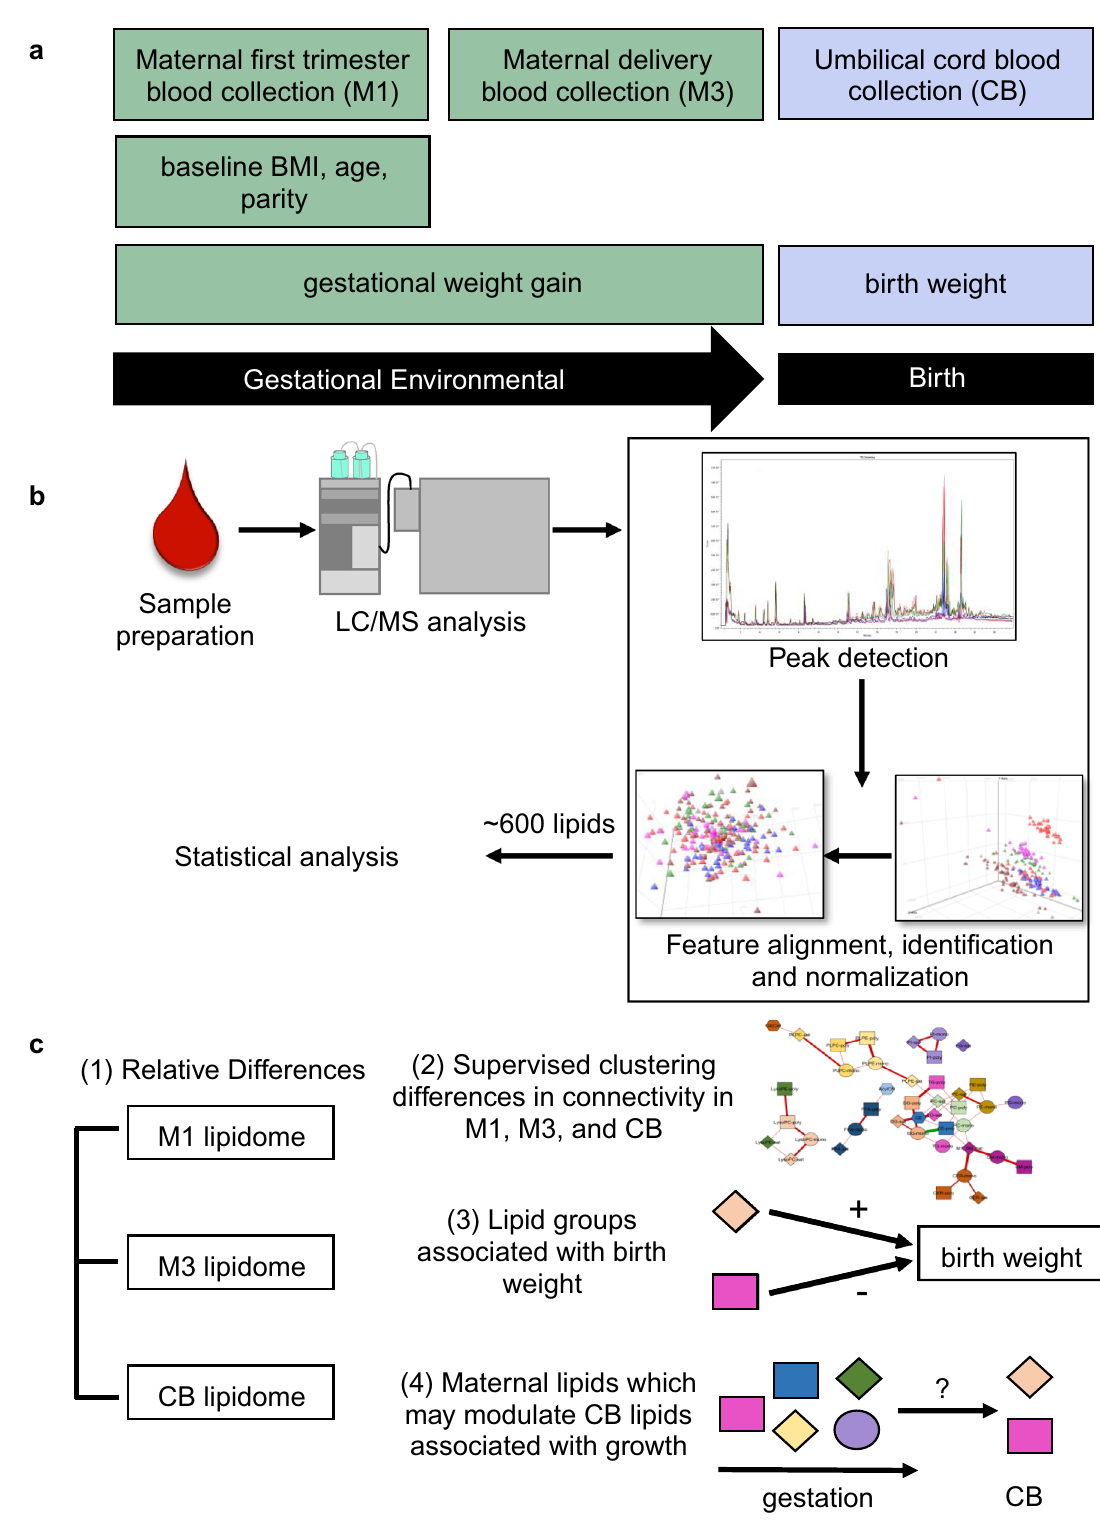
Figure 1. Study design and lipidomics analysis strategy. ( a ) Women were recruited into the Michigan Mother-Infant Pairs Study at their first prenatal appointment between 8 and 14 weeks pregnancy (M1). Venous blood samples were collected at this visit, along with weight, height, and demographic information. At delivery, maternal venous blood samples (M3) and cord blood samples via venipuncture from the umbilical cord (CB) were collected, as well as birth weight. ( b ) Untargeted shotgun lipidomics was conducted on maternal first trimester, delivery, and cord blood plasma. After peak detection and data normalization, 573 lipids of multiple classes were identified. ( c ) Statistical analysis for this manuscript classified (1) relative differences in the lipidome across pregnancy (paired t-test), (2) differences in the connections of lipid groups between M1, M3, and CB (debiased sparse partial correlations), (3) lipid groups associated to birth weight (linear regression), and (4) M1 and M3 lipids that may modulate CB lipids significantly related to birth weight (Pearson’s